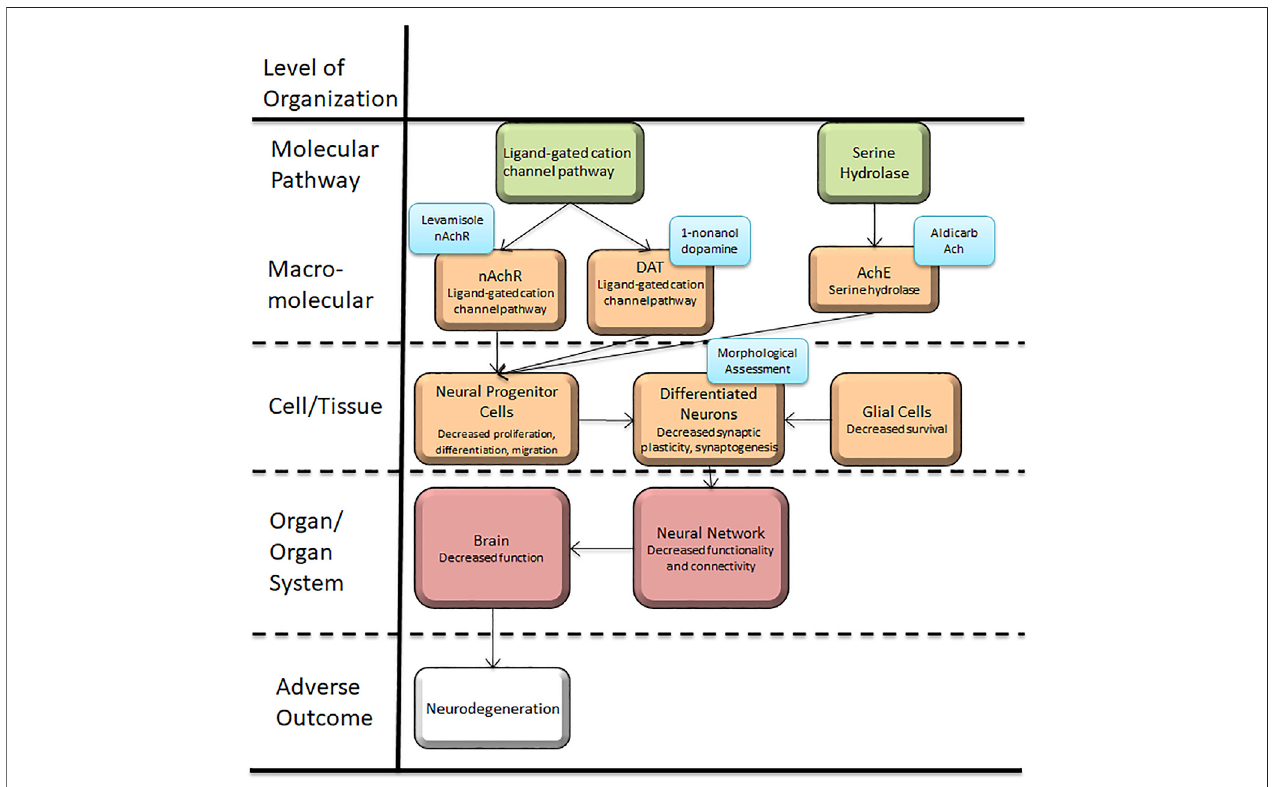
FIGURE1| Caenorhabditis elegans neurotoxicitytesting intheAdverseOutcomePathwayFramework.Thisarticlepresentsasetofbehavioraland morphological assessmentprotocolsrelatedtoacetylcholineanddopamineneuronsandfunctionin C.elegans ,whichisapplicabletoconservedsystemsintargetorganismsusingthe AOPframework.Theseassayscanprovide newinformationtofurtherthemechanistic studiesand hazard assessments related toAlzheimer ’ sand Parkinson ’ sdisease.